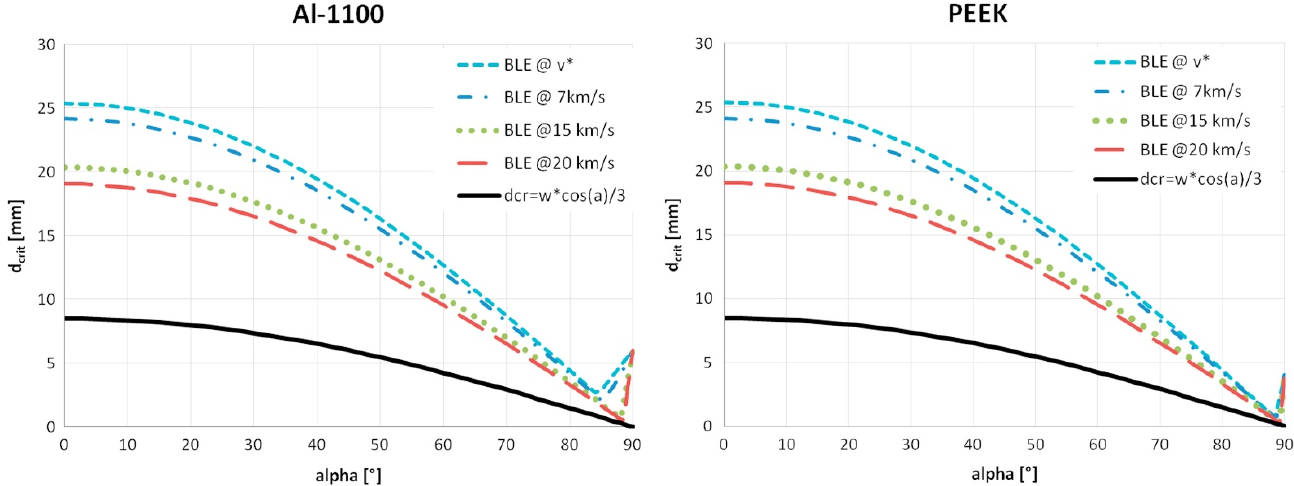
Figure 3. Aluminum ( left ) and polymeric (PEEK, right ) tape tethers’ ballistic limit in respect of the impact angle (alpha) and impact velocity; d CRIT represents the critical impacting particle diameter.